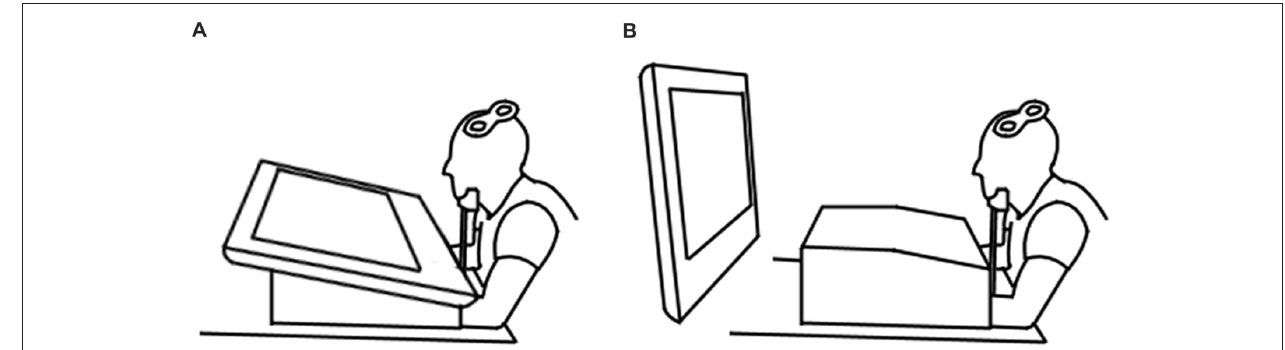
FIGURE 1 | Experimental setup demonstrating the horizontal (A) and vertical (B) screen positions.